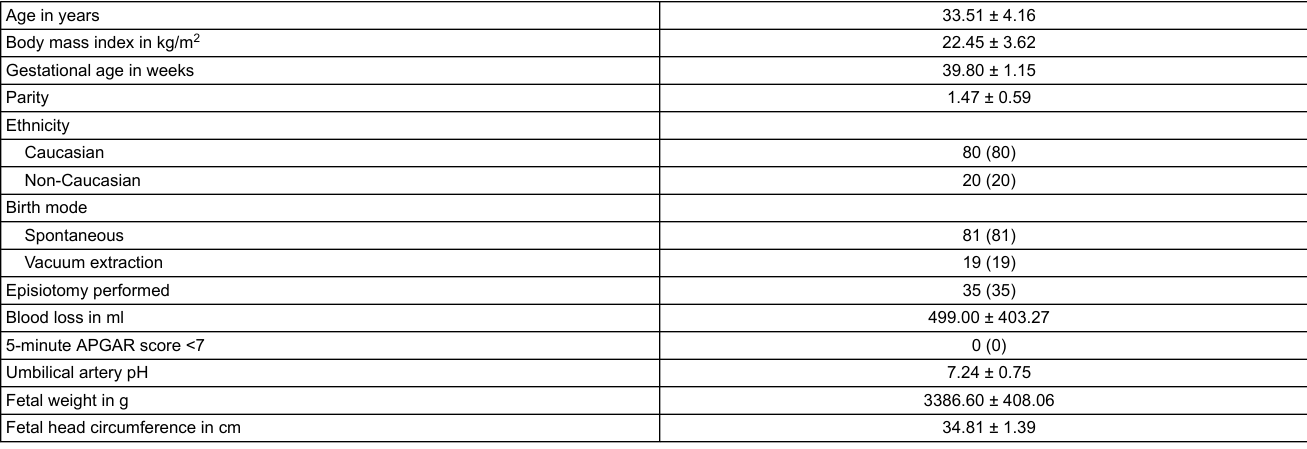
Table 2: Characteristics of the study population.